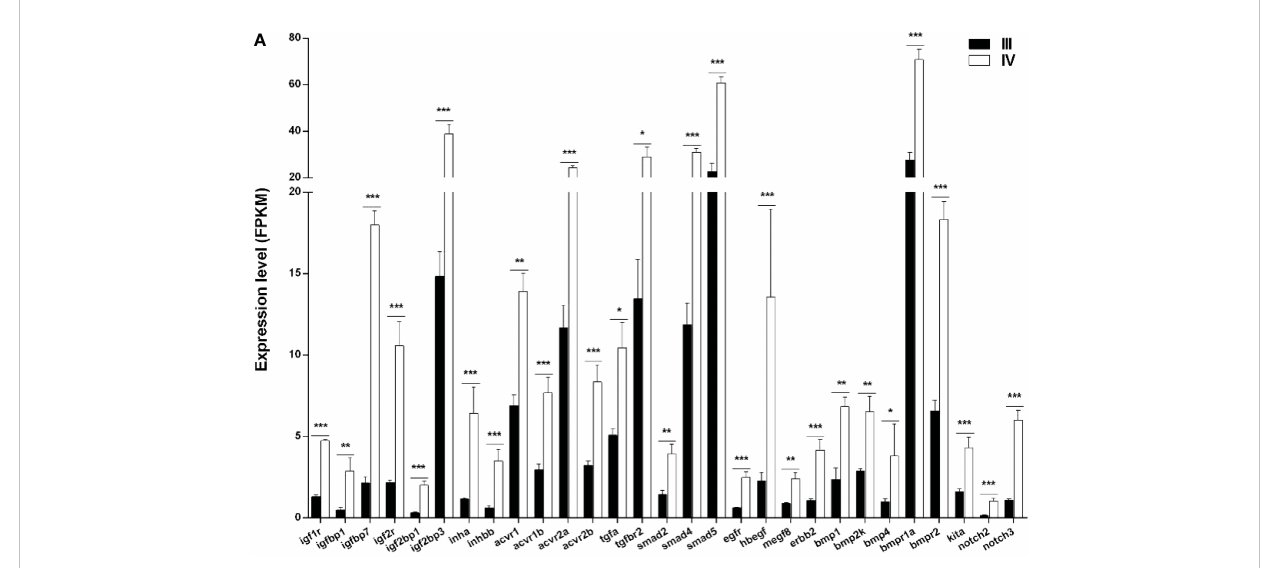
FIGURE 8 Histogram showing the selected differentially expressed genes (log2 (FC) >1 and FDR <0.05) involved in paracrine signaling in stage III and IV ovary of S. argus . The data is based on the FPKM values obtained from the RNA-seq data. *, P<0.05; **, P<0.01; ***, P<0.001.